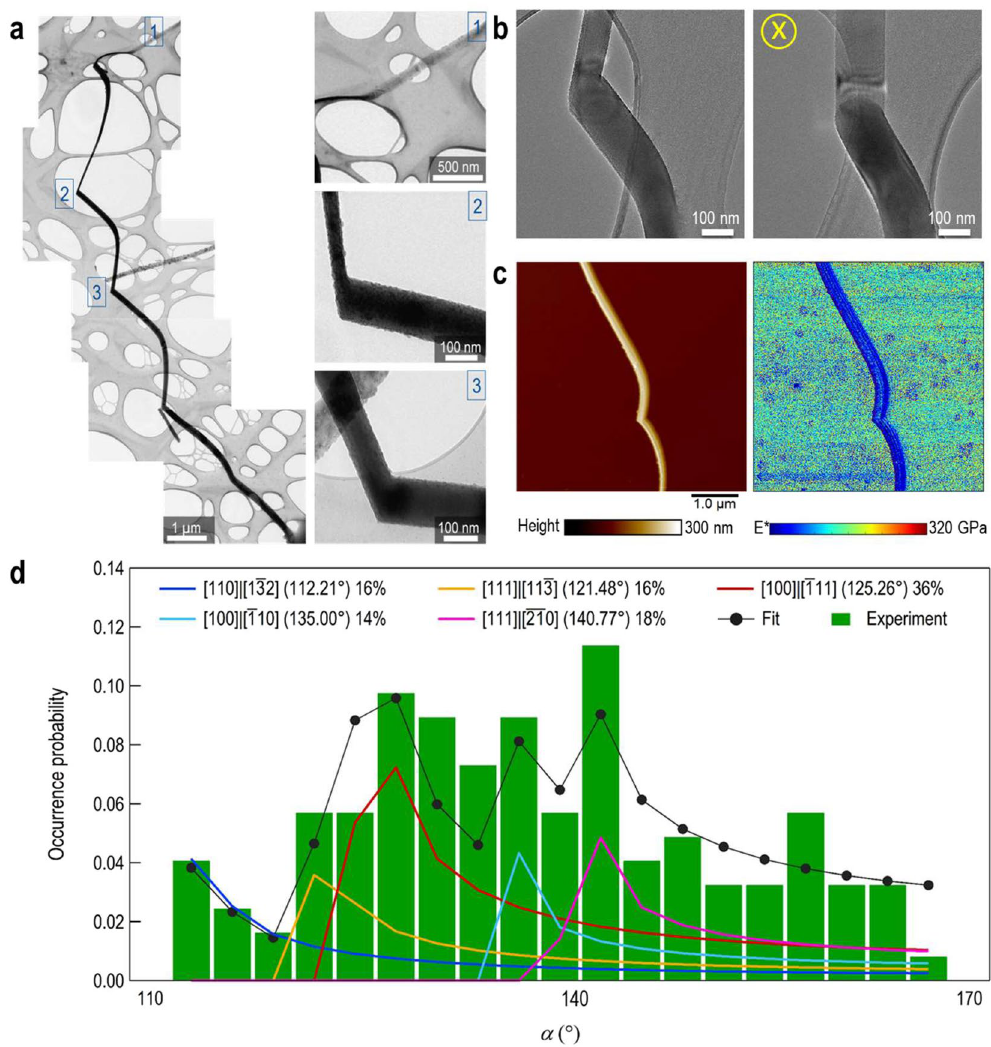
Figure 2. k-SiNWs characterization. TEM image for a k-SiNW obtained by metal assisted chemical etching on a < 100 > Si substrate, showing the porous segment as well as details on the kinks with different angles between adjacent segments ( a ). Tomography TEM images of the kink revealing the elliptical shape upon tilting of the sample ( b ). Height and effective elastic modulus AFM maps of a SiNW kink with 𝛼 = 120°, confirming that the mechanical stiffness at the kink is similar to the straight segment of the nanowire, as depicted by the color- coded scale bar ( c ). The scan size of images is 5 × 5 µ m 2 . Occurrence probability distribution of the measured 𝛼 in SEM along with the least squares fit ( d ). The fitted model gives the distribution of angles formed by pairs of crystallographic directions, as seen from the top. Major contributions are provided by the two most probable pairs of etching directions: < 100 > - < 111 > ( 𝛼 = 125.26°) and < 111 > - < 210 > ( 𝛼 =